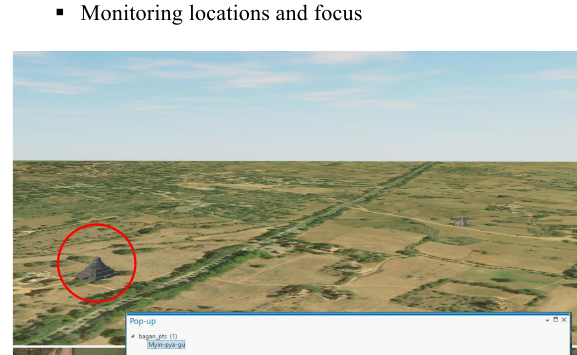
Figure 10. Earthquake position and impact in relation to the documented